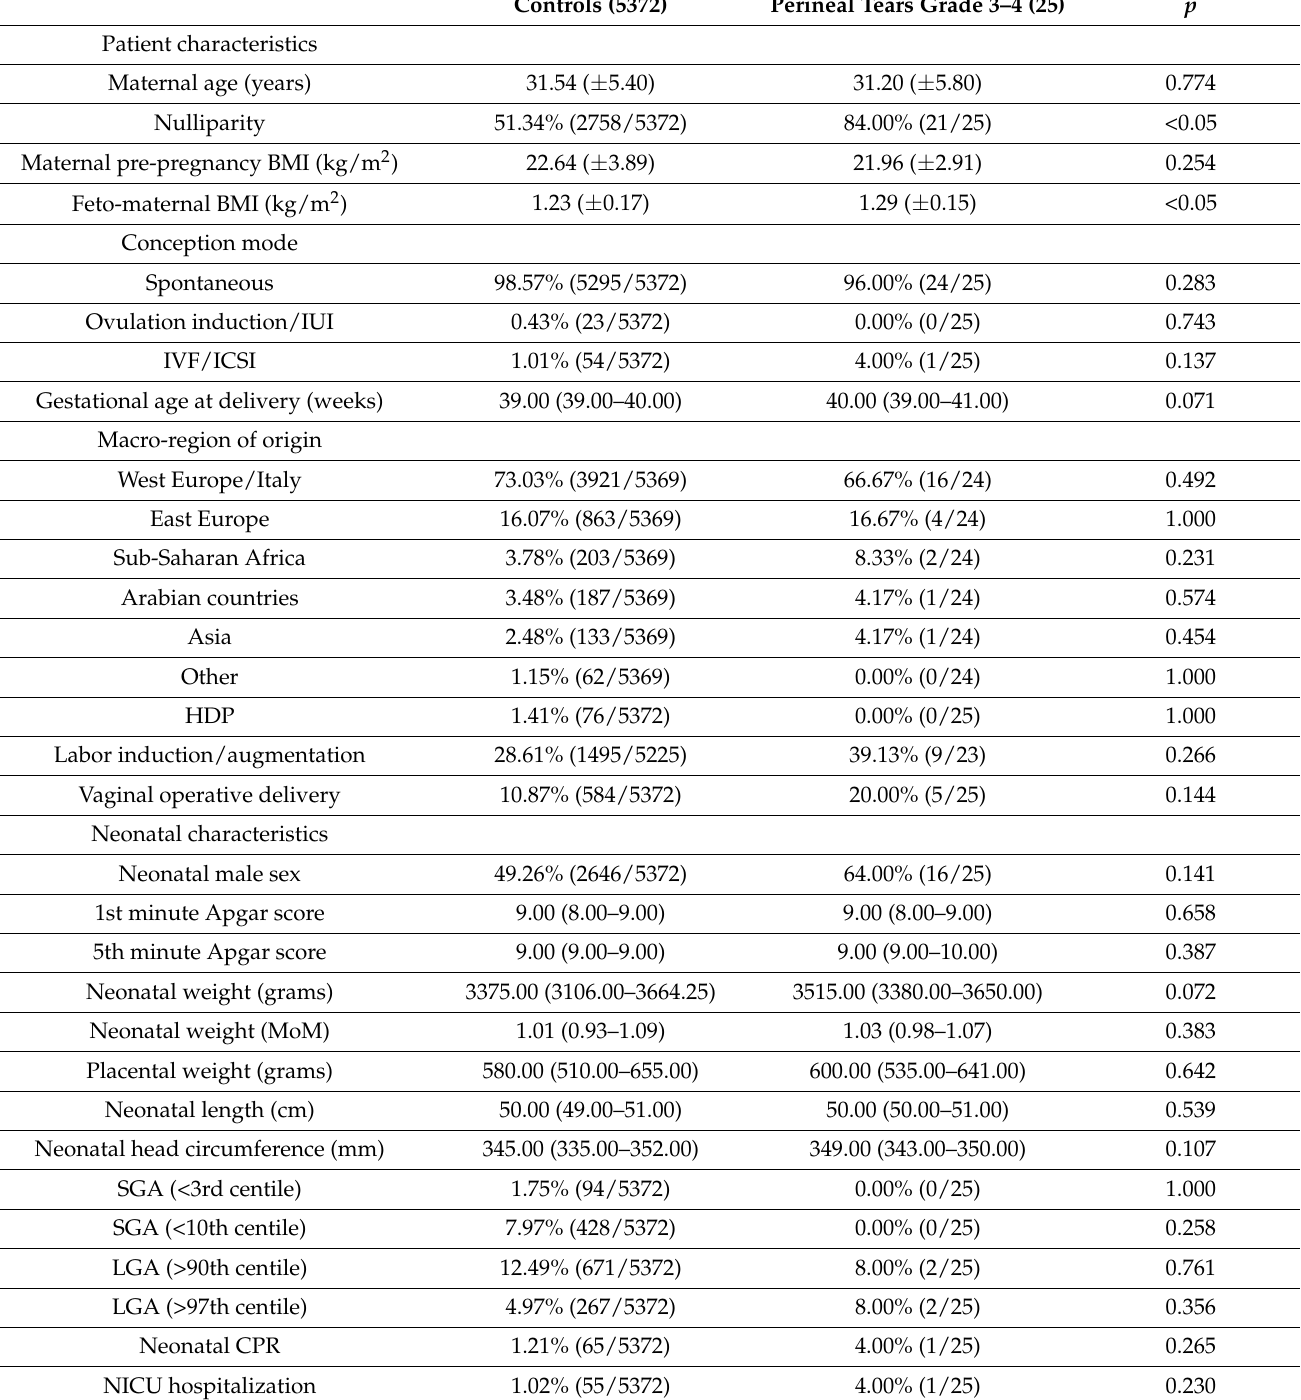
Table 2. Comparison between pregnancies with and without grade 3–4 perineal